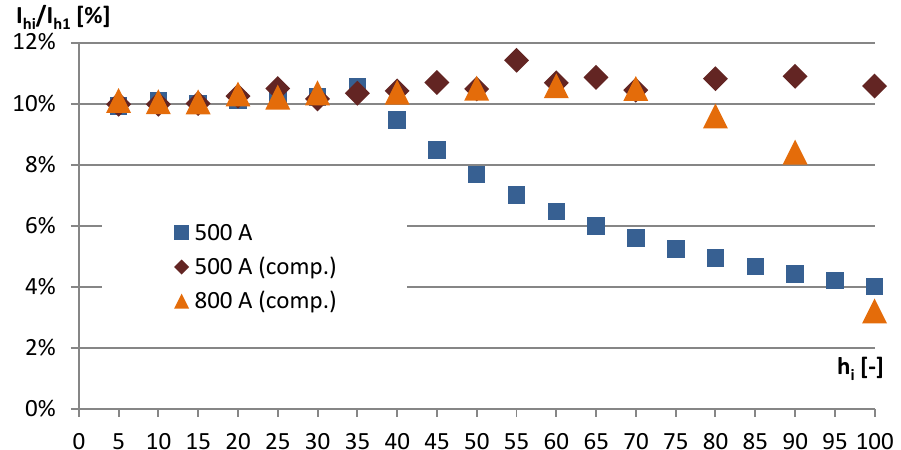
Figure 14. The frequency band of operation of the power system with audio amplifier for a required rms value of its main component of the output current with and without compensation.